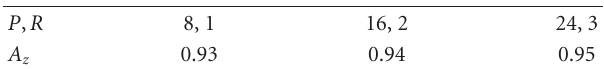
Table 4: Classification rates when using di ff erent number of rotation invariant rows under settings of ( P , R ) = (8,1), ( P , R ) = (16,2), and ( P , R ) = (24,3).